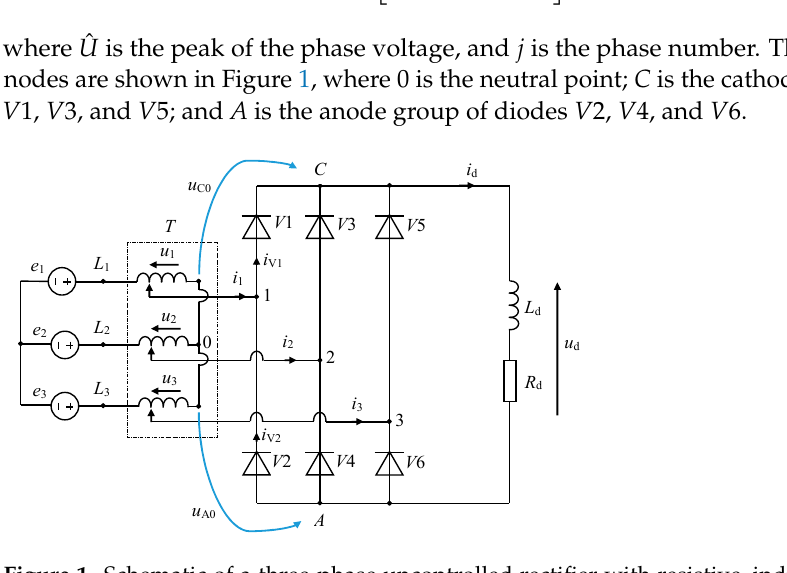
Figure 1. Schematic of a three-phase uncontrolled rectifier with resistive–inductive load; 0 is the neutral point; C is the cathode group of diodes V 1, V 3, and V 5; and A is the anode group of diodes V 2, V 4, and V 6.